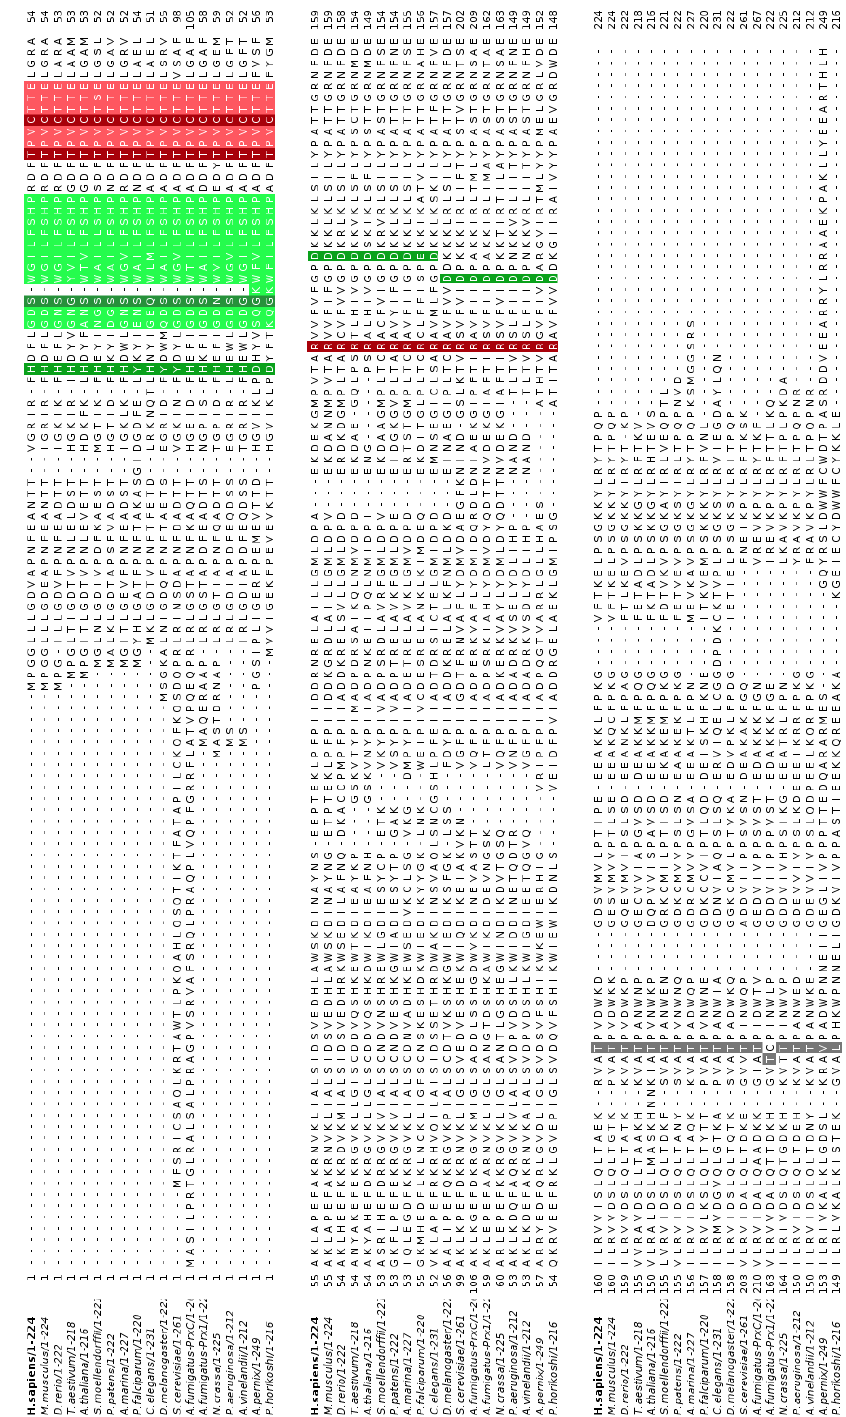
Figure 1. Alignment of representative Peroxiredoxins class 6 (Prdx6) enzymes from organisms that belong to diverse phylogenetic groups. Lysosomal putative target sequence (light green), phospholipase A 2 (PLA 2 ) catalytic triad (dark green), Prdx6 peroxidase motif (light red), peroxidatic catalytic triad (dark red) and the Thr that is putatively subjected to phosphorylation (gray) are highlighted.